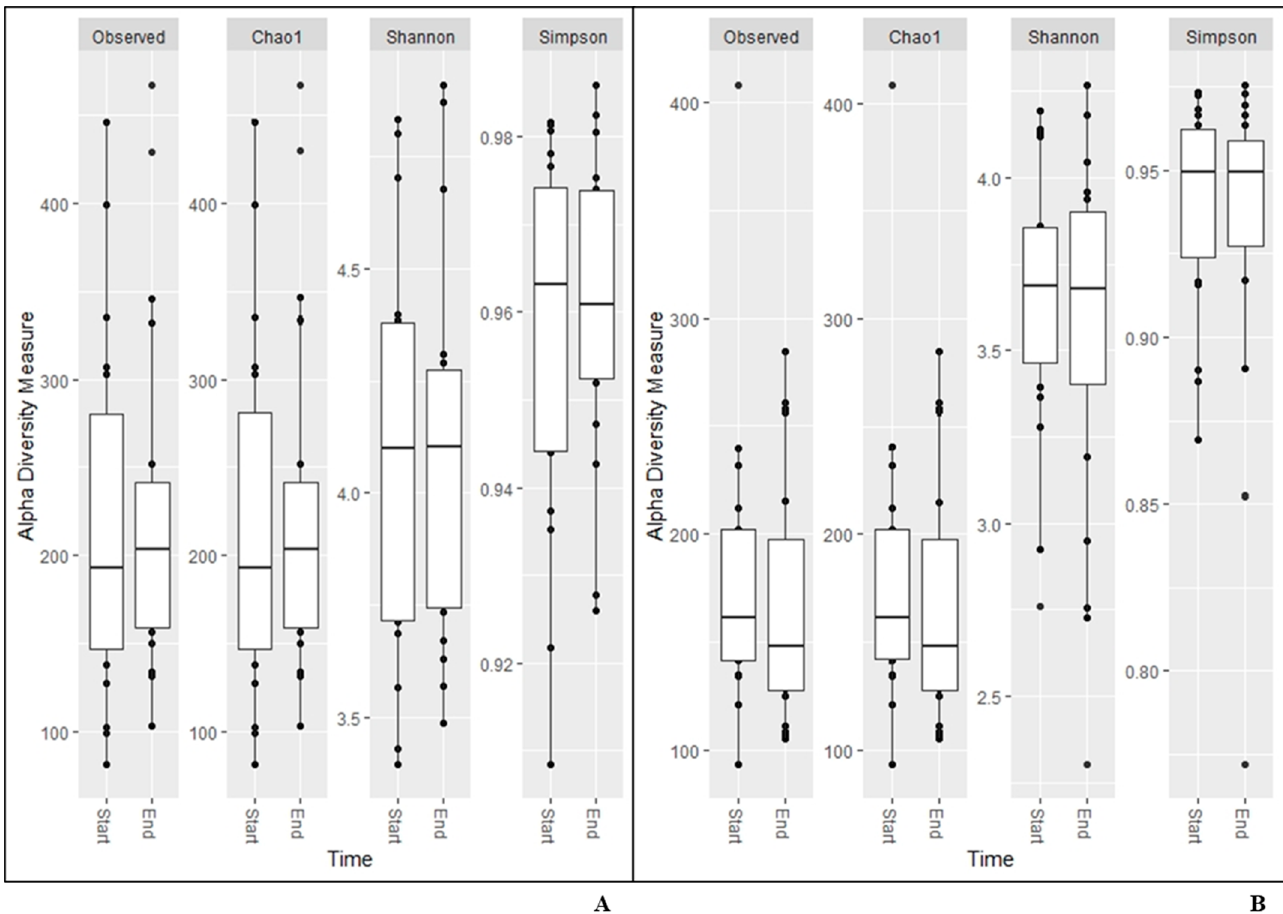
Figure 1. Alpha diversity measurements for saliva ( A ), and faecal ( B ) samples.